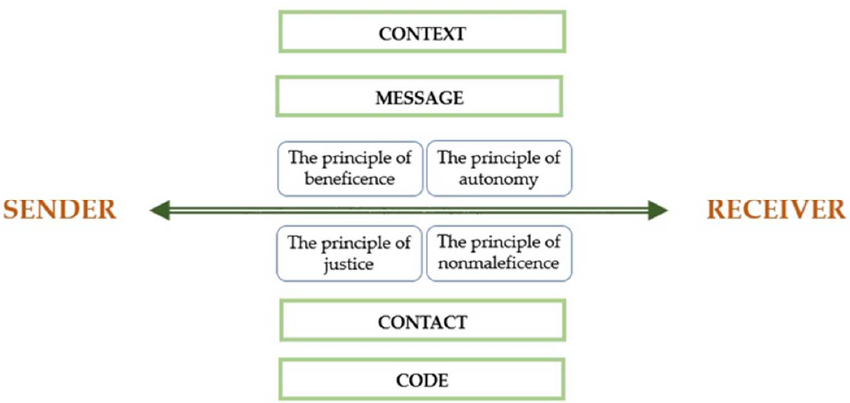
Figure 1. Roman Jakobson’s model of the communicative functions of language with ethical principles in translational research in audiology. Source: own elaboration based on Jakobson, R. Linguistics and Poetics. In Style in Language; Sebeok, T., Ed.; M.I.T. Press: Cambridge, USA, 1960; pp. 350– 377.